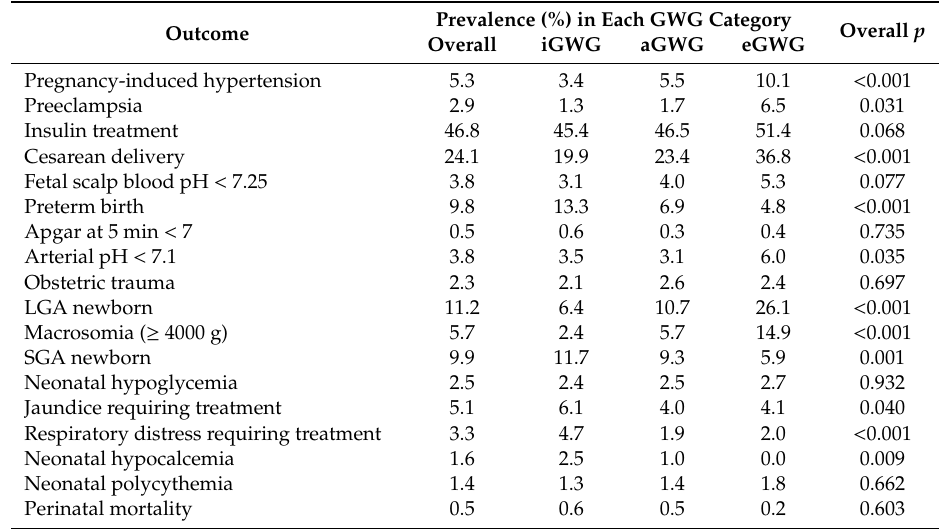
Table 3. Pregnancy outcomes of women with gestational diabetes mellitus according to gestational weight gain category. Prevalence (%) in Each GWG